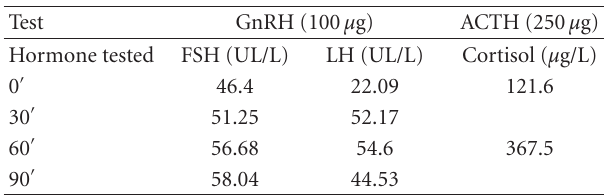
Table 3: Dynamic endocrine tests.